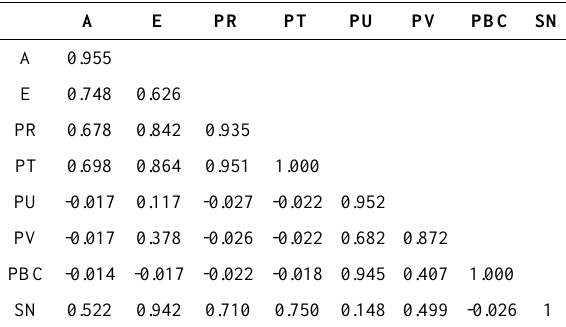
Table 7. Fornell-Lacker Criterion (Discriminant